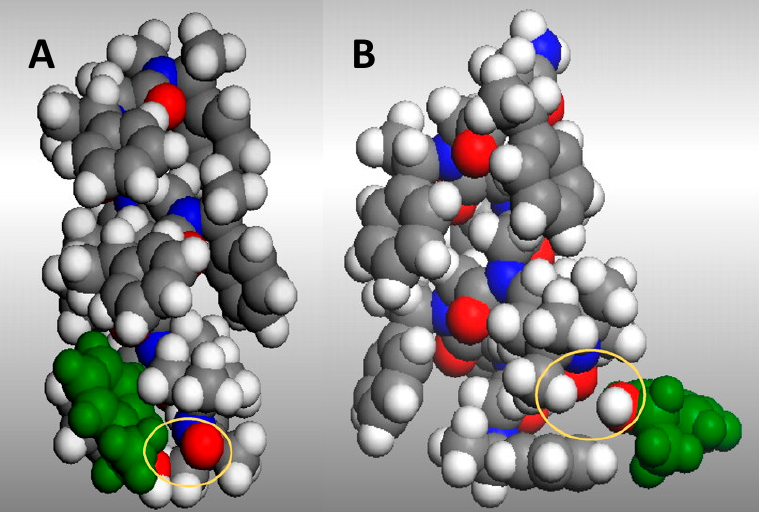
Figure 5. ( A ) Model of energy-minimized structure of the catalytic peptoid 1S with substrate 1- phenylethanol. ( B ) Model of energy-minimized structure of the catalytic peptoid 4S with substrate 1-phenylethanol. Colors: hydrogen, white; oxygen, red; nitrogen, blue; 1-phenylethanol (substrate), green. Adapted with permission from [30].